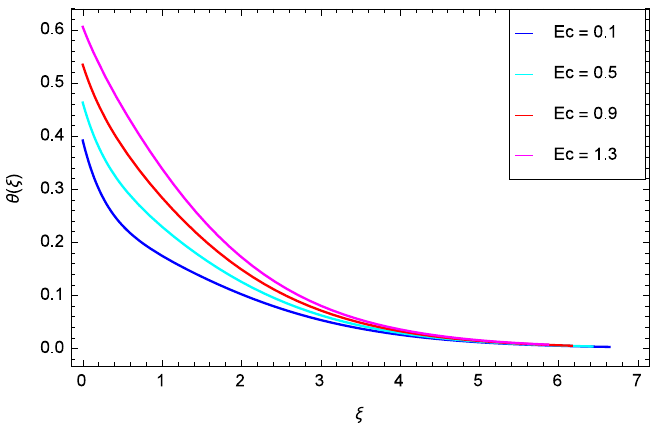
Figure 12. Impact of the Eckert number Ec on temperature θ ( ζ ) .